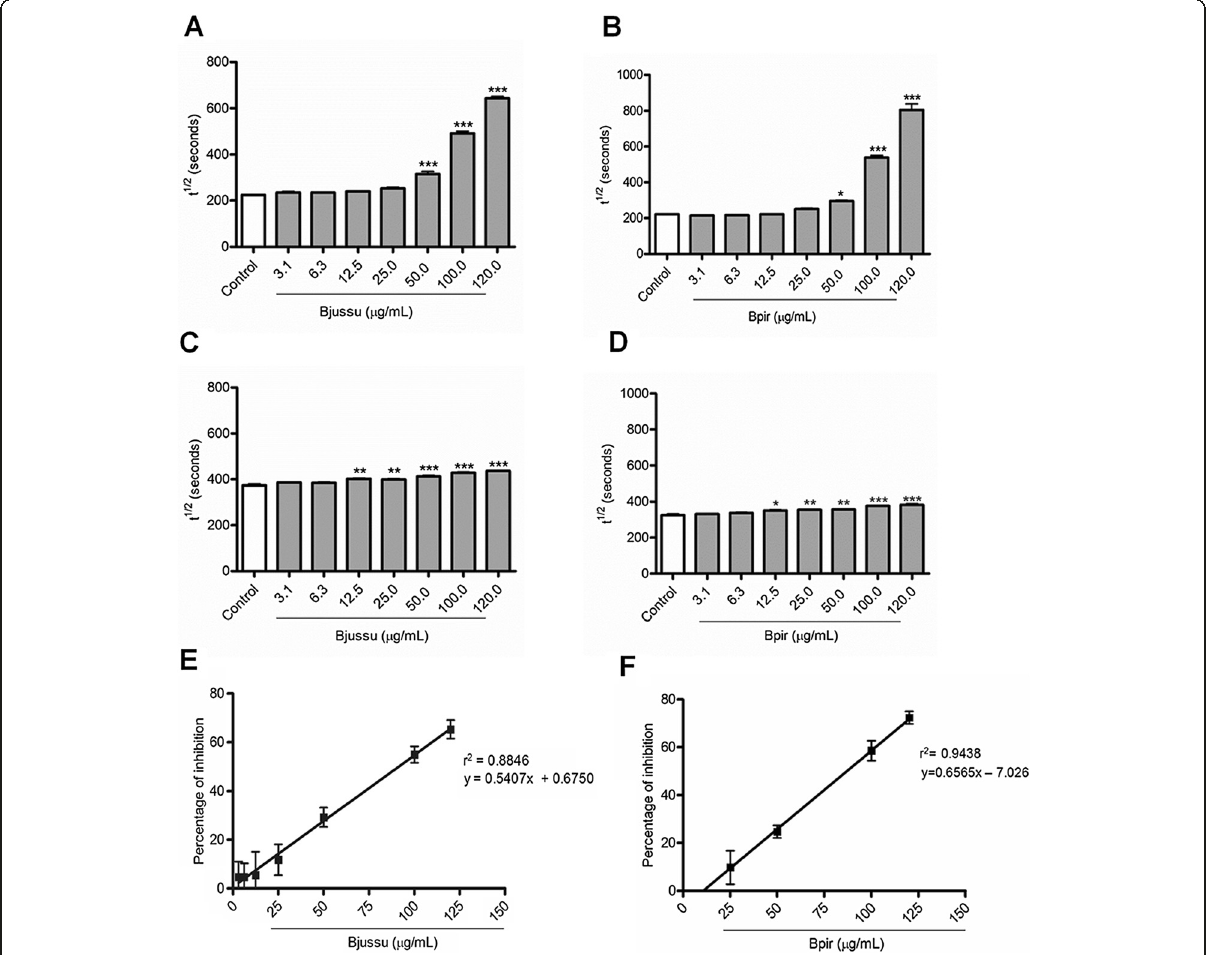
Fig. 1 Effect of Bjussu and Bpir crude venom on the hemolytic activity of the complement system. This figure depicts the concentration-dependent inhibitory effect of ( a , c , and e ) Bjussu and ( b , d , and f ) Bpir crude venoms on the hemolytic activity of the ( a , b , e , and f ) classical and ( c and d ) alternative pathways of the complement system. Panels a to d : Control represents normal human serum incubated with buffer alone. Data are expressed as the mean±standard deviation of the t ½ values obtained for each venom concentration, based on three (CS-CP/LP) or two (CS-AP) independent experiments assayed in triplicate. * p <0.05, ** p <0.001, or *** p <0.0001 vs. control. Panels e and f : Linear regression graph, where the X-values represent the amount